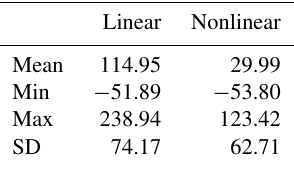
Table 3. Descriptive statistics of the deviation (in mm) between measured and estimated annual groundwater recharge